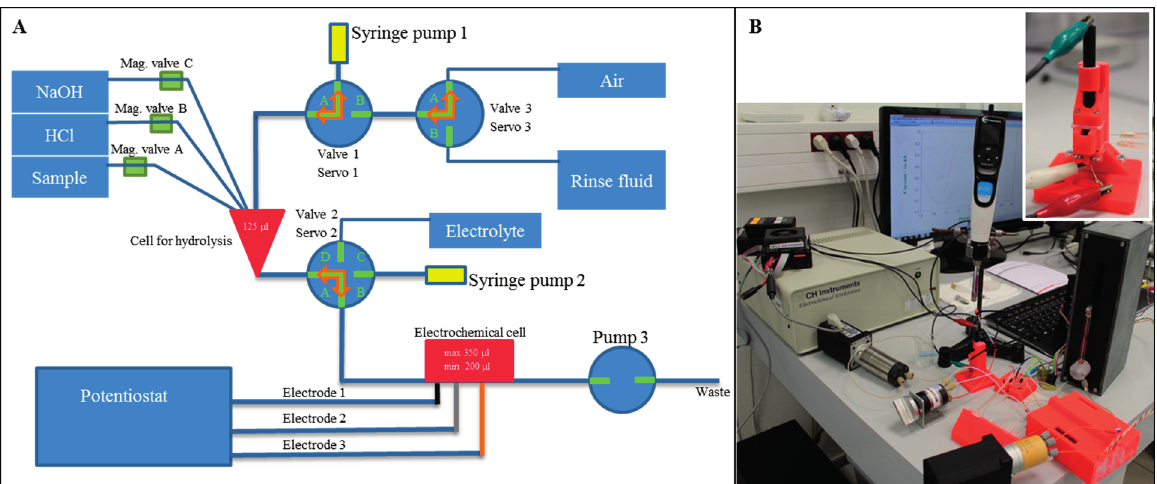
Figure 4. ( A ) The scheme of the microfluidic system composed of the hydrolysis and detection parts; ( B ) Picture of the fabricated microfluidic system and detailed picture of the chip with integrated